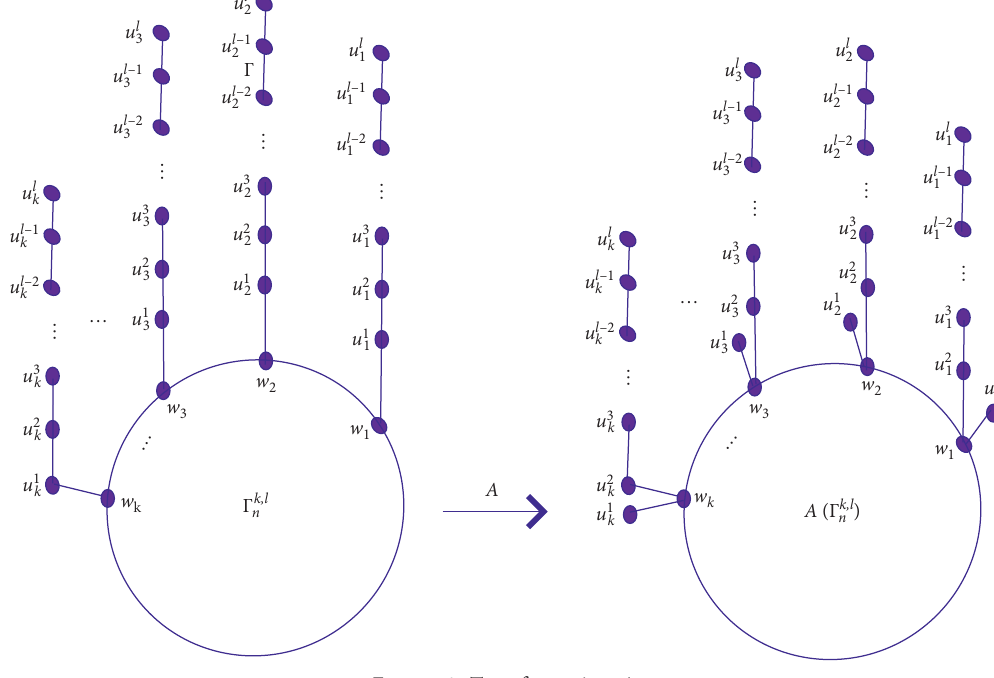
Figure 2: Transformation A